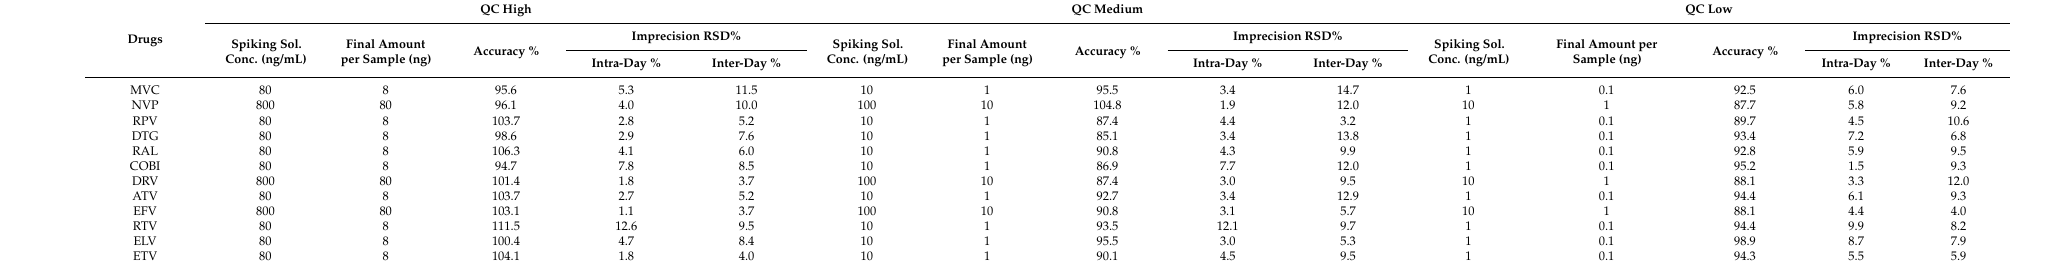
Table 2. Summary of quality controls (QCs) final amount, accuracy, intra-day, and inter-day precision (relative standard deviation, RSD) for all